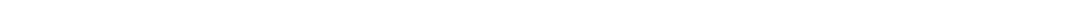
Table5.Differentvariables/determinantsandtheircorrelationwiththelevelofperception. Thequestionnaire was a Likert scale and for ease of study, scores were divided into two. Strongly disagree, disagree, and neutral was combined to be called ‘ poor perception in favour of lectures ’ , and strongly agree and agree were combined to get one score and to be called ‘ good perception favour of lectures ’ . This was done to get a clear distinction between the perception of students to have or not to have